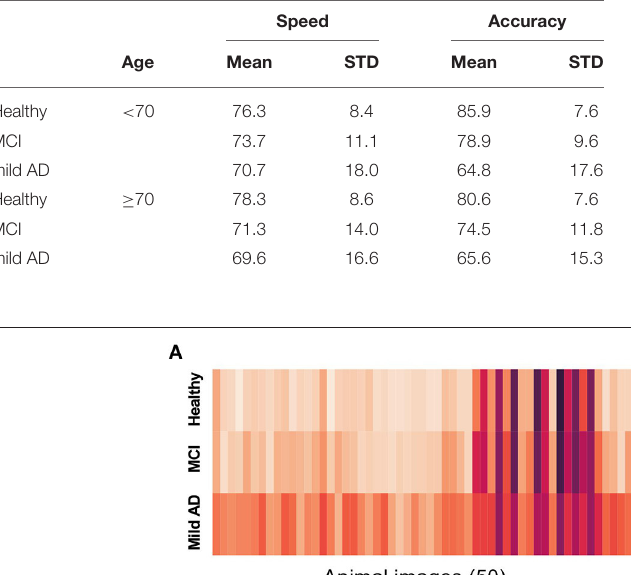
TABLE 4 | Mean speed and accuracy on the ICA test, by age category and diagnosis.